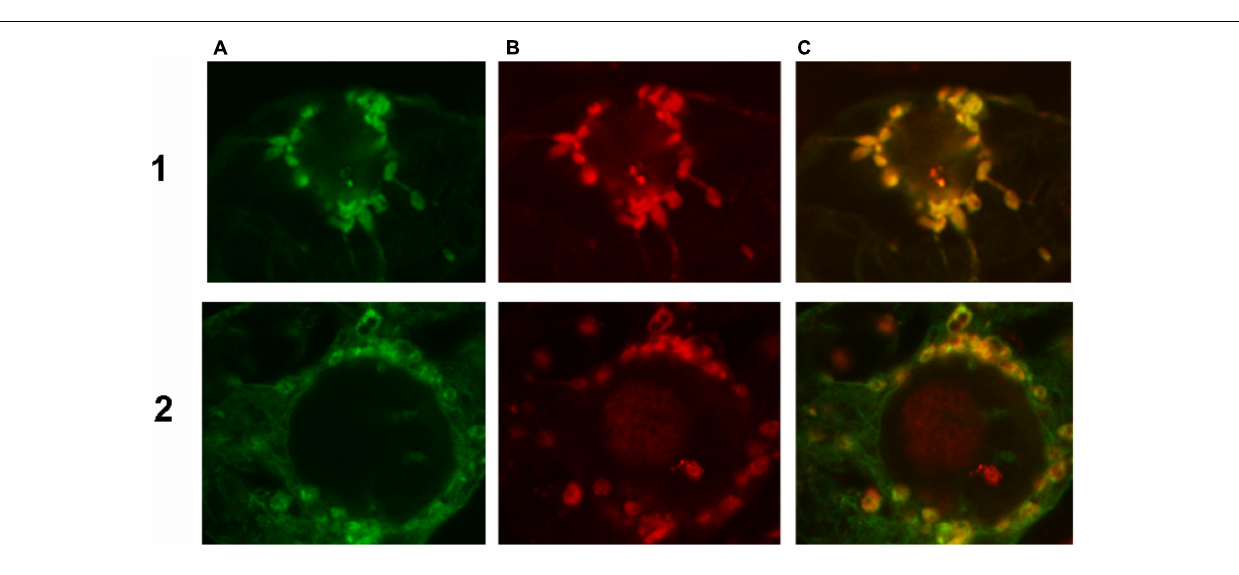
FIGURE 7 | Representative confocal laser scanning microscopy images of green fluorescent protein (GFP)-tagged Ha FatA or Ha FatB expressed transiently (via biolistic bombardment) in BY-2 tobacco cells. Images in column (A) show FatA-GFP row (1) and FatB-GFP row (2) , while those in column (B) represent